Question: According to this chart, does the measure grow or shrink?
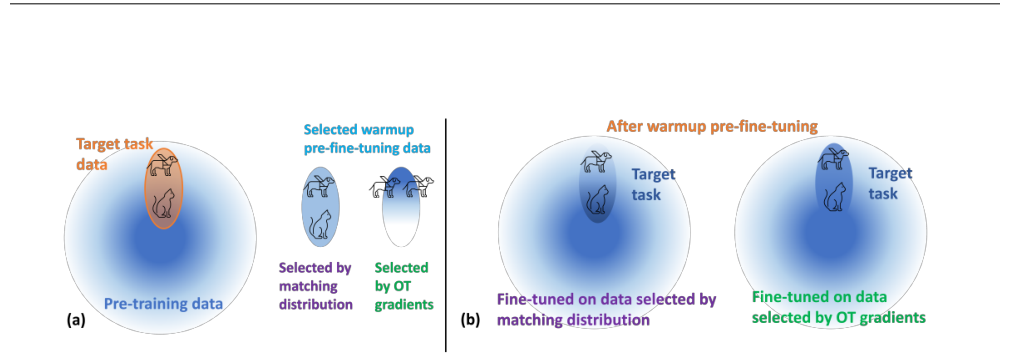
Answer: increasing